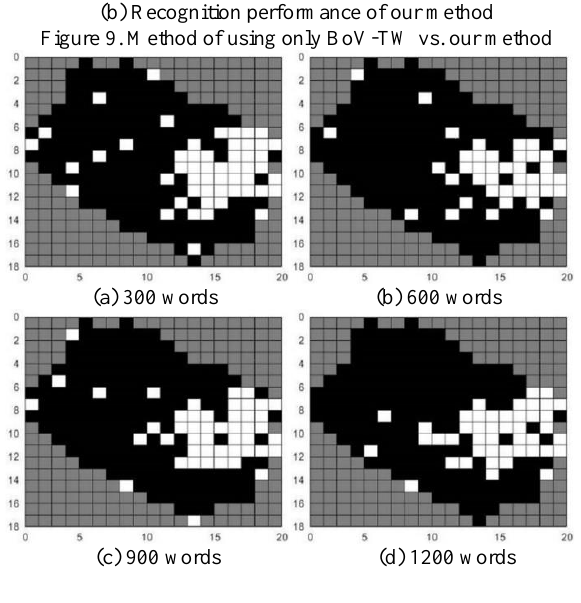
Figure 9. Method of using only BoV-TW vs. our